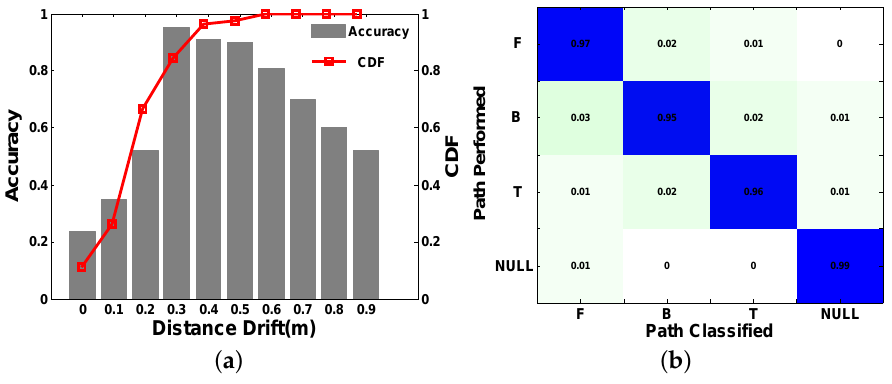
Figure 14. System performance. ( a ) Communication distance between antenna and tags; ( b ) Confusion matrix of motion